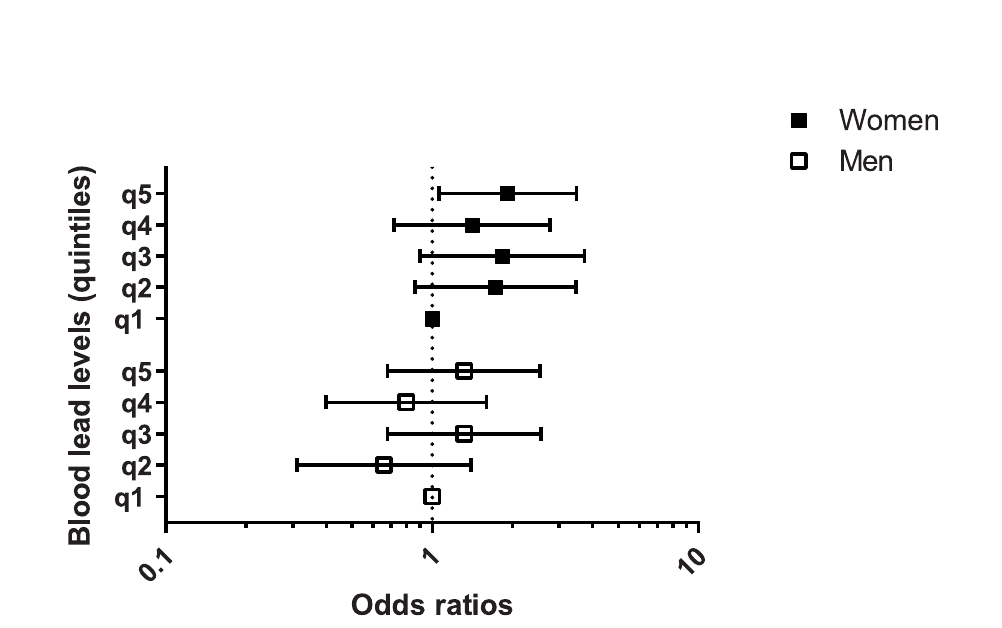
Fig 3. The odds ratio of any AMD by quintile of blood lead level, stratified by